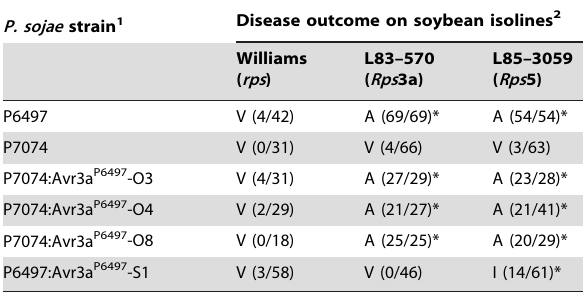
Table 3. Virulence characteristics of P. sojae wild-type strains P6497 and P7074 and Avr3a -transformed